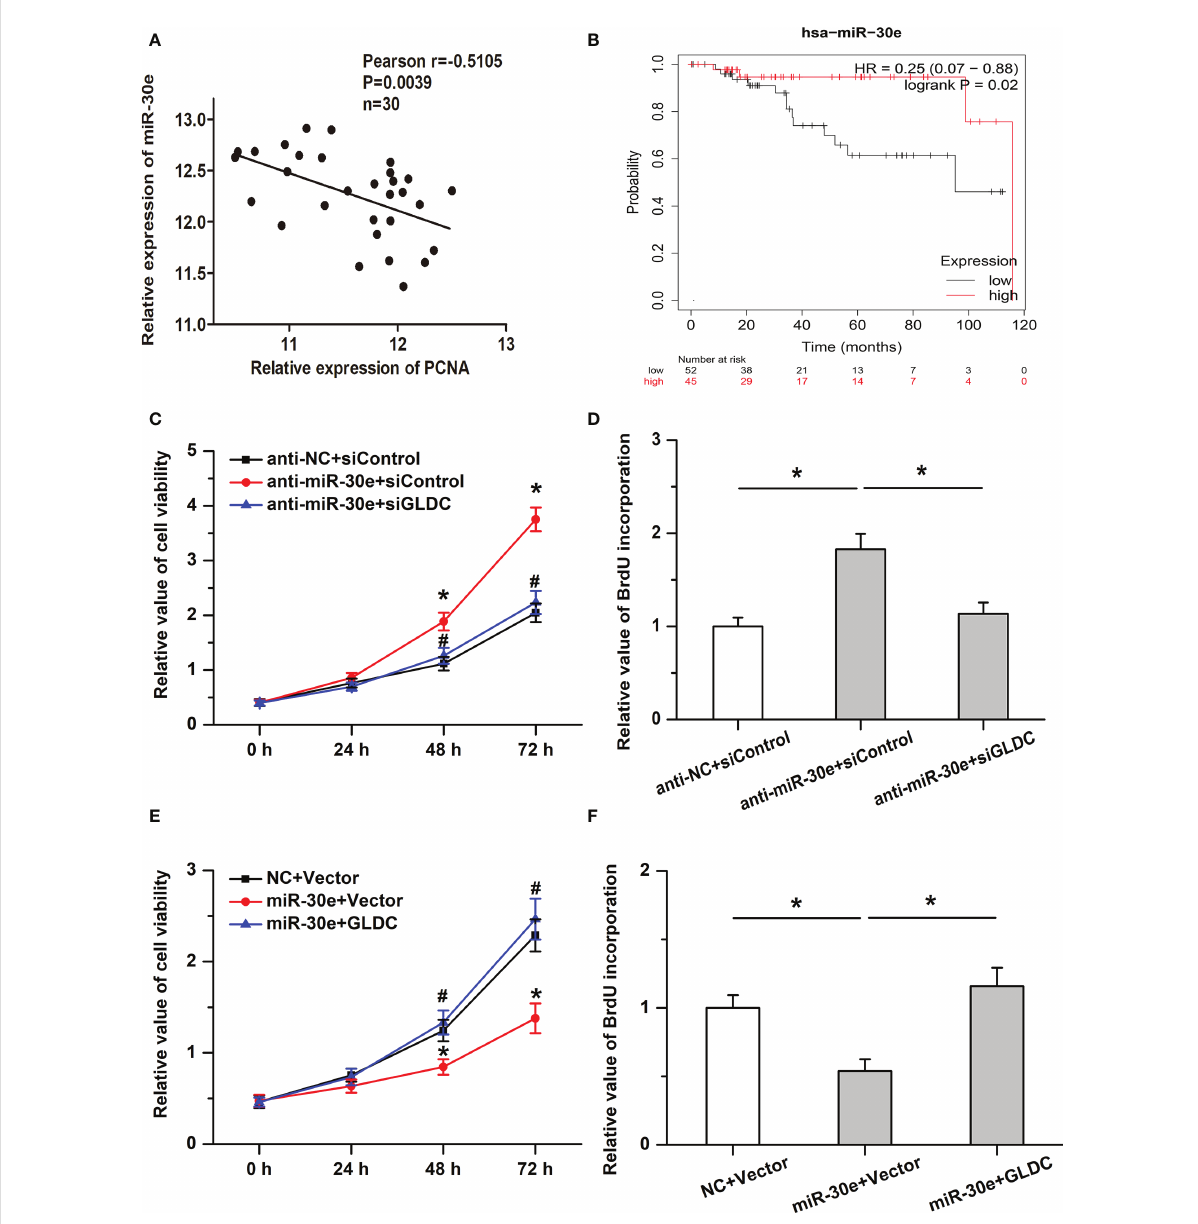
FIGURE 6 The inhibitory effects of miR-30e on cell proliferation are mitigated by GLDC. (A) The expression of miR-30e was negatively correlated with PCNA expression in the same TNBC tissues. (B) High levels of miR-30e were associated with better overall survival. (C, D) Treatment with anti- miR-30e increased cell viability (C) * indicates p < 0.05 compared with anti-NC+siControl group, # indicates p < 0.05 compared with anti-miR- 30e+siControl group and promoted BrdU incorporation. (D) , which was attenuated by the knockdown of GLDC. (E, F) : Restoration of GLDC depressed the regulatory effects of miR-30e on cell viability (E) * indicates p < 0.05 compared with NC+Vector group, # indicates p < 0.05 compared with miR-30e+Vector group and BrdU incorporation (F)